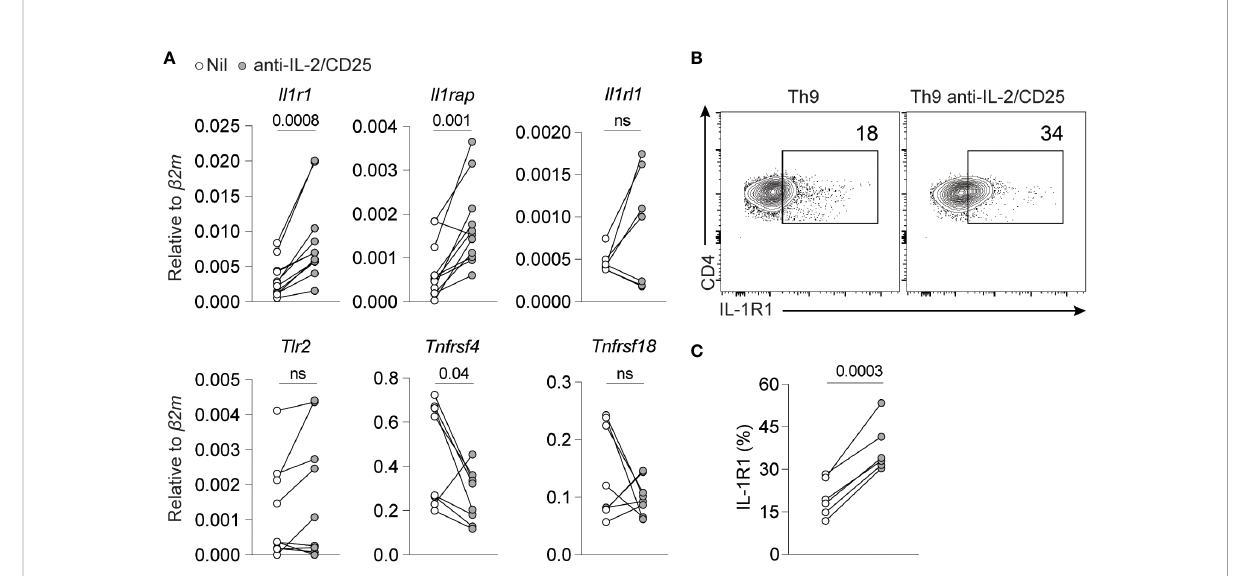
FIGURE 4 IL-2 limiting conditions enhance IL-1R1 expression on Th9 cells. (A) NF-KB-inducing cell surface and cytokine receptor gene expression in standard Th9 or IL-2-deprived Th9 cells. Each point represents data from one mouse. The combined data represent at least a n=7 mice. (B) Representative contour plots of cell surface IL-1R1 expression on Th9 and IL-2-deprived Th9 cells on day 5 of culture. (C) Quanti fi cation of IL-1R expression from panel (B) Data are representative of Th9 cultures from 6-7 mice pooled from 3 individual experiments. Data were considered signi fi cantly different from paired t -test at p value ≤ 0.05. ns, non-signi fi